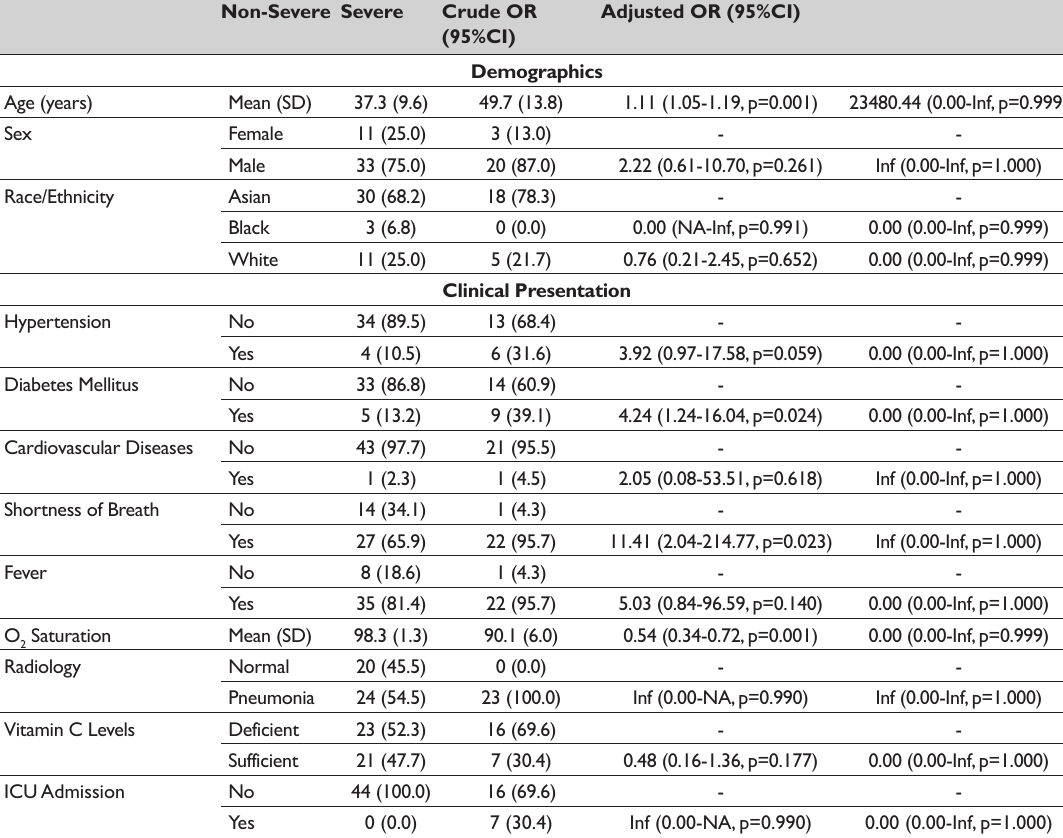
Table 3: Predictors for COVID-19 severity using univariate and multivariate logistic regression analysis Non-Severe